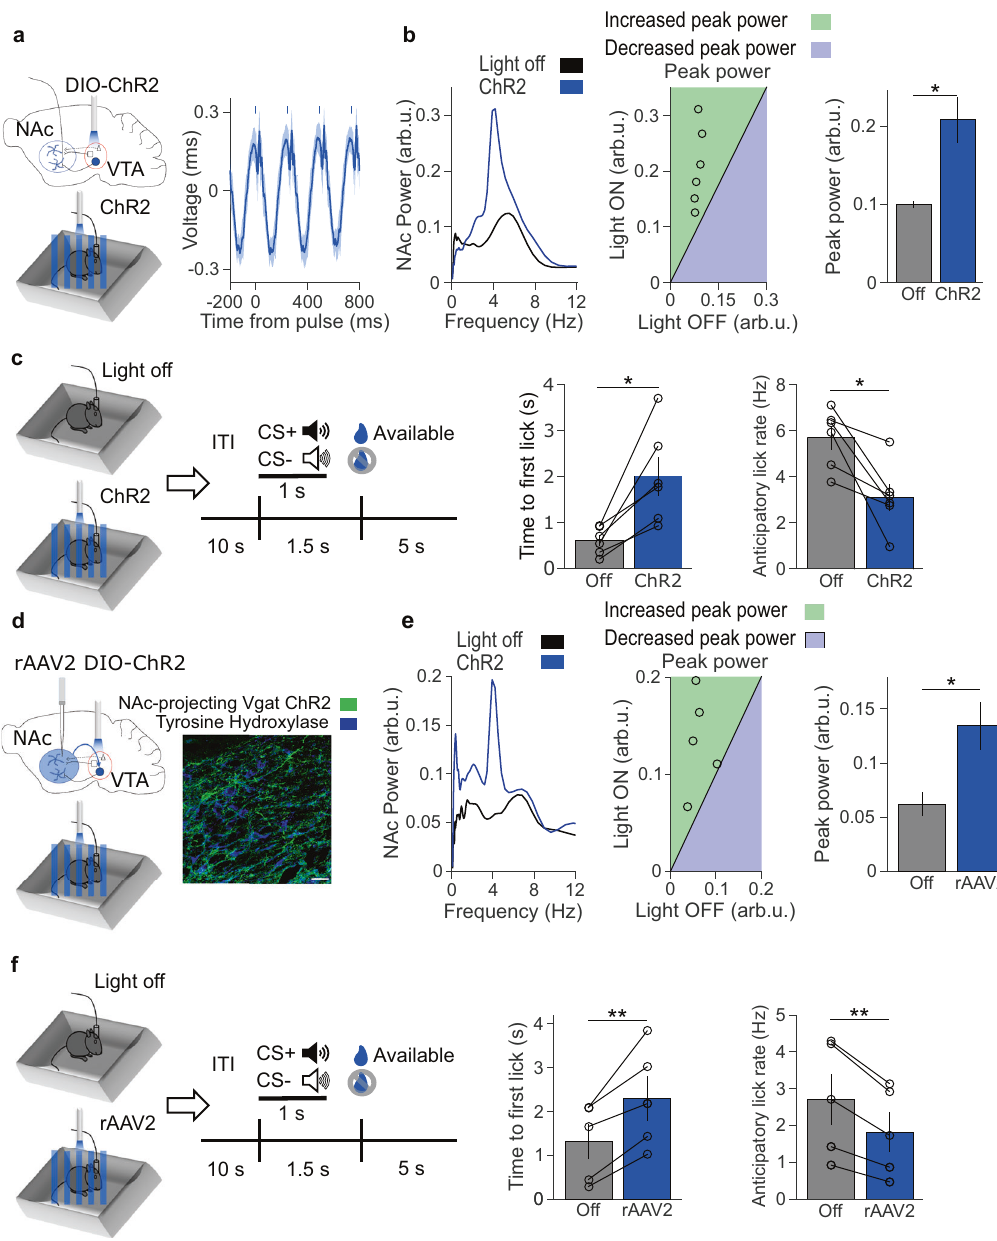
Fig. 6 Activation of NAc-projecting VTA GABA neurons produces a low-frequency oscillation and impairs reward-seeking. a Left: experimental design. Right: event-related potential of NAc LFP. Bars indicate 10 ms laser pulse onset. b Left: representative NAc spectra with no stimulation (black) and rhythmic low-frequency stimulation (blue). Center: relationship between max 4 Hz NAc power during light off and stimulation, with a line of equality for reference. Right: summary of data from the center panel. ChR2 stimulation increased peak 4 Hz NAc power (* P = 0.031 two-tailed signed-rank test, n = 6 mice). Data are mean ± s.e.m. c Left: experimental design. Right: rhythmic ChR2 stimulation impaired subsequent reward retrieval latency and anticipatory lick rate (* P = 0.031 and * P = 0.031, two-tailed signed-rank test, n = 6 mice). Data are mean ± s.e.m. d Left: experimental design. Right: immuno fl uorescent image of retrograde ChR2 expression (green) in a Vgat-ires-Cre mouse VTA, with tyrosine hydroxylase counterstain (blue). The scale bar is 30 µ m. Representative of fi ve experiments. e Left: representative NAc spectra of no stimulation and rhythmic low-frequency stimulation. Center: relationship between max 4 Hz NAc power during light off and stimulation, with the line of equality for reference. Right: Summary of data from the center panel. Stimulating NAc- projecting VTA GABA neurons increased peak 4 Hz NAc power (* P = 0.040 two-tailed paired t test, n = 5 mice). Data are mean ± s.e.m. f Left: experimental design. Right: rhythmic VTA illumination impaired subsequent reward retrieval latency and anticipatory lick rate (** P = 0.0091 and ** P = 0.0057 two-tailed paired t test, n = 5 mice). Data are mean ±